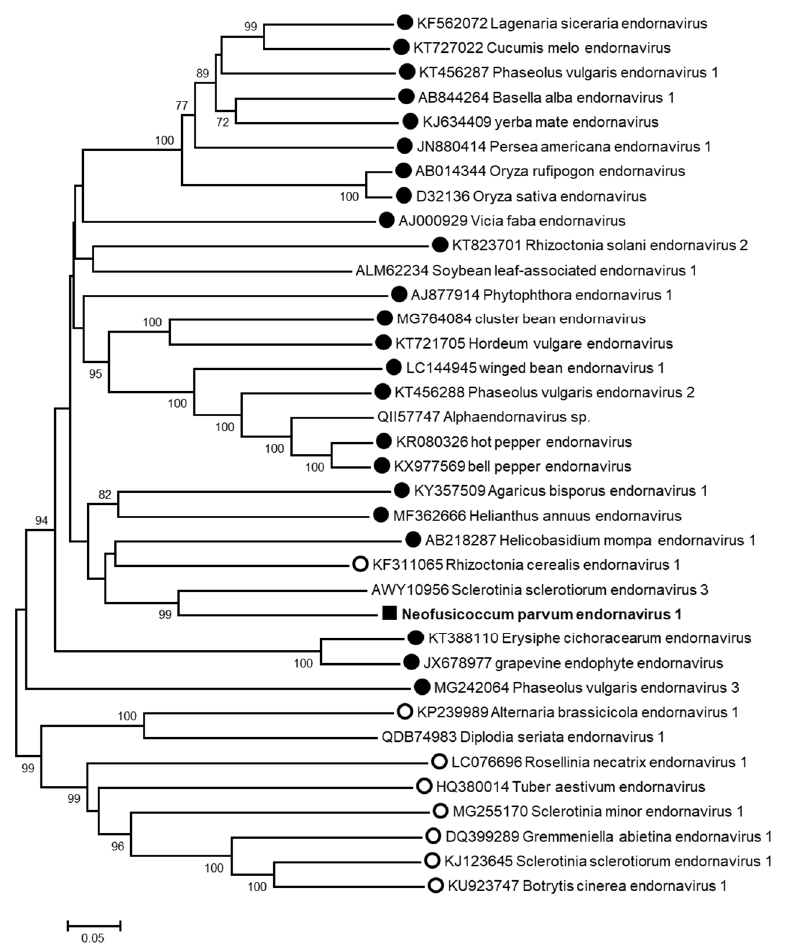
Figure 3. Unrooted phylogenetic tree reconstructed from the alignment of the amino acid sequences of the RdRp domains of Endornaviridae representative members. The tree was constructed by the neighbor-joining method and the statistical significance of branches was evaluated by bootstrap analysis (1000 replicates). Only bootstrap values above 70% are indicated. The scale bar represents 5% amino acid divergence. Species belonging to the genera Alphaendornavirus and Betaendornavirus are identified respectively by a filled or an open circle. Neofusicoccum parvum endornavirus 1 is in bold and indicated by a black square.